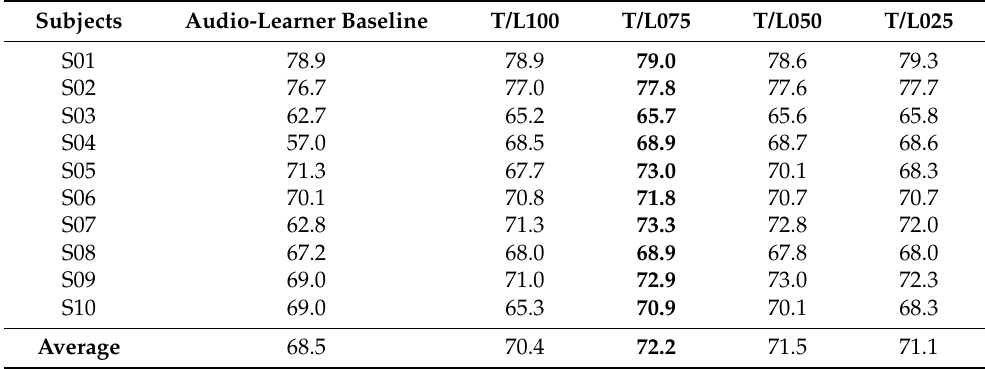
Table 8. Relationship to compare the performance of the audio-learner average classification (ex- pressed in percentage) model trained over the T/L approach in contrast to the baseline. Subjects Audio-Learner